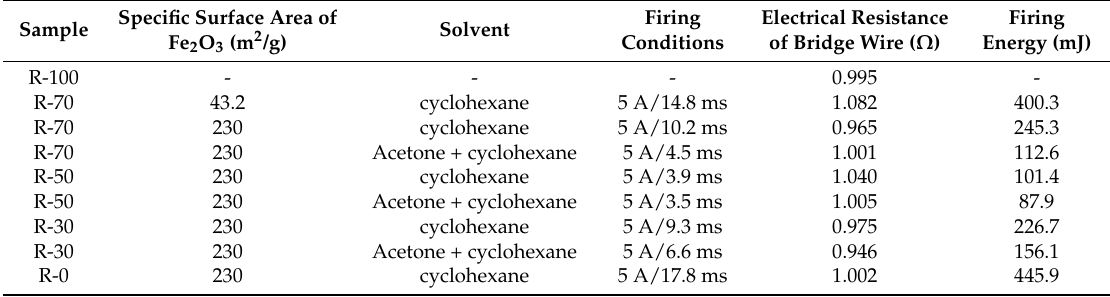
Table 5. Hot bridge wire sensitivities of Al/Fe 2 O 3 /RDX